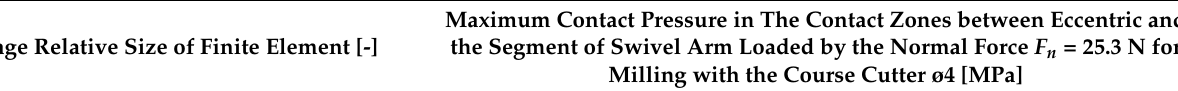
Table 10. The maximum values of normal contact pressure in the contact zones between eccentric and the segment of swivel arm for various average finite element sizes.